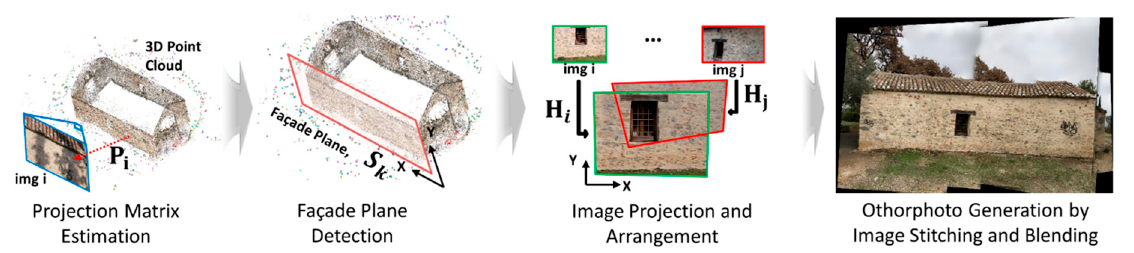
Figure 4. Several high-resolution façade images (orthophotos) generated for each TOC by automatically detecting major planes from a point cloud generated from collected images.